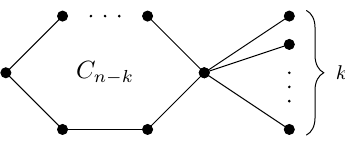
Figure 1: The graph C